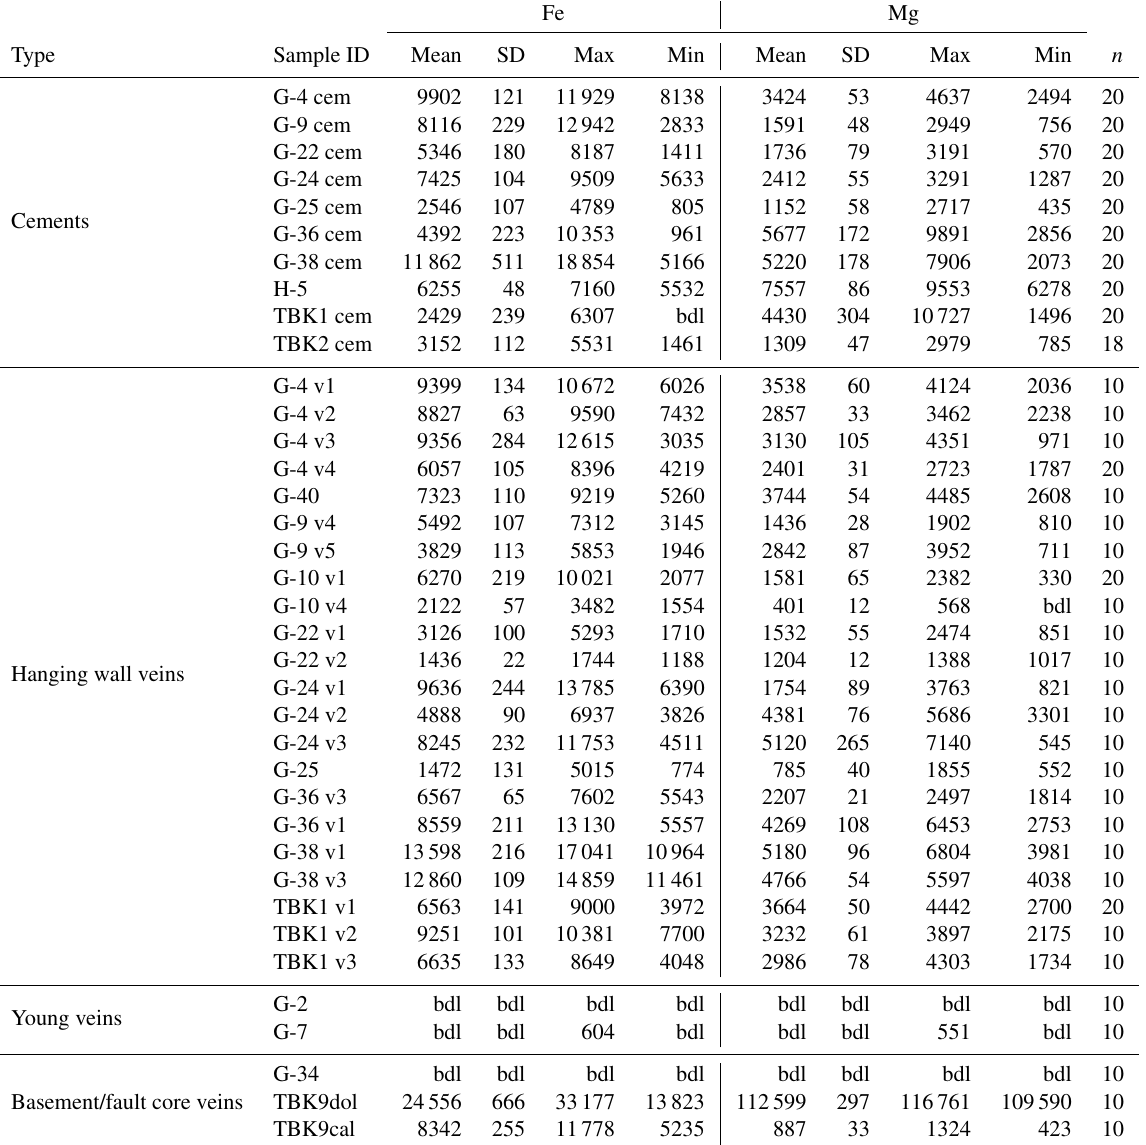
Table 3. Minor element concentration (in ppm) of calcite cements and veins derived from microprobe analysis (bdl indicates values below detection limit; n indicates the number of